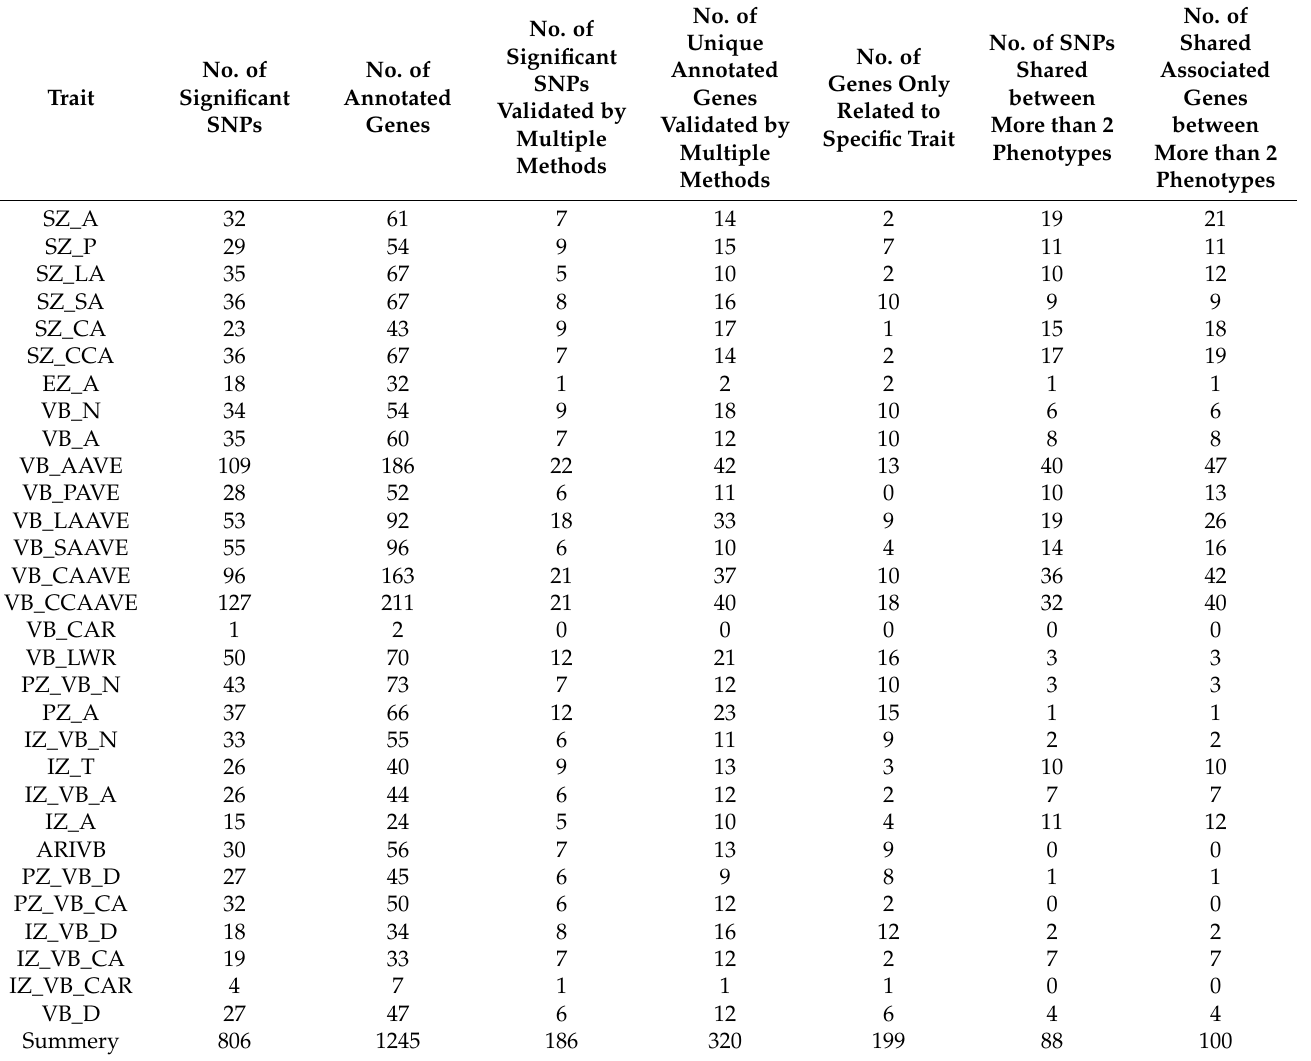
Table 3. Summary of significant loci from the genome-wide association